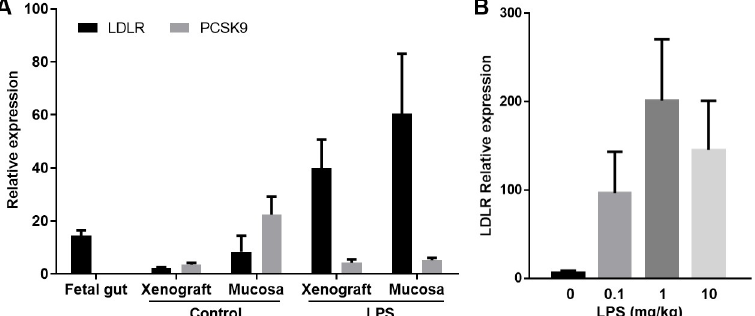
Fig 1. LPS treatment increase LDLR and suppress PCSK9 genes expression in human gut xenografts. Human fetal gut was transplanted into SCID mouse and allowed to develop over 12 weeks. Mice with fully developed gut xenografts were systemically treated with 10 mg/kg LPS by intraperitoneal injection (A). Dose response experiments (0.1–10 mg/ kg LPS) demonstrated the utility of lower LPS dose (0.1 mg/kg) to increase the expression of LDLR in human gut xenografts (B). Normal fetal gut before transplantation, and normal and LPS-treated whole xenografts and mucosal scrapings were harvested for RNA extraction and QPCR analysis 4 hours after LPS treatment or PBS as control treatments. Graphs show mean ± SEM of relative